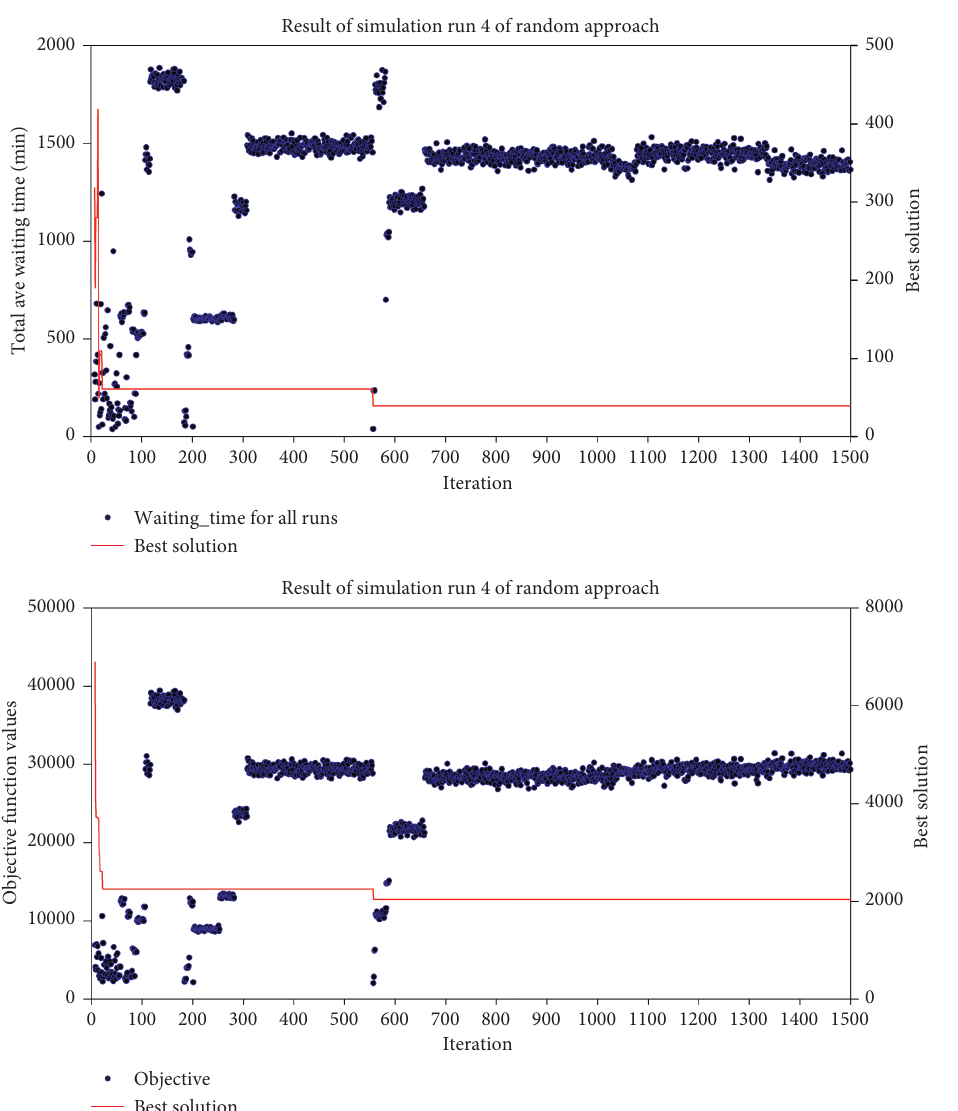
Figure 3: SA optimisation results using the random method of creating new